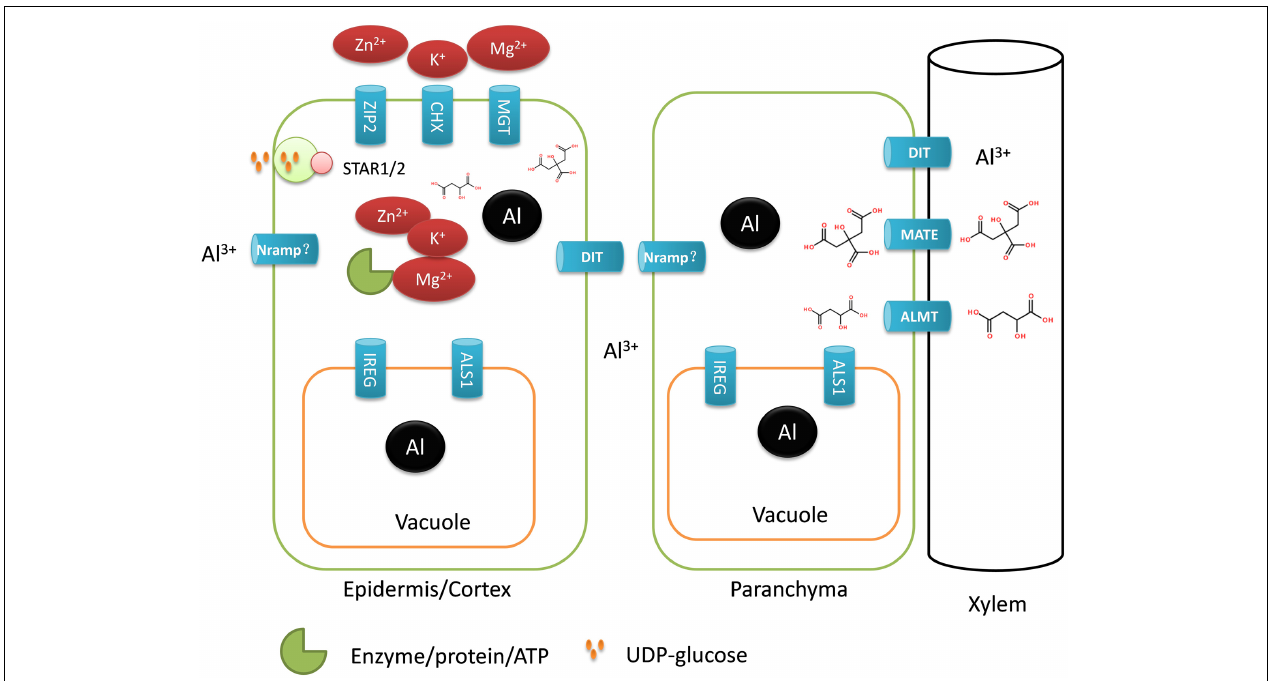
FIGURE 3 | Schematic model for the involvement of putative transporter genes in Al uptake, detoxification, compartmentation, and translocation in buckwheat. ALS1, aluminum sensitive1; DIT, divalent ion transporter; CHX, CATION/H + EXCHANGER; MGT, magnesium transporter; ZIP2; ZINC INDUCED FACILITATOR-LIKE 1; STAR1/2, sensitive to aluminum rhizotoxicity1/2; ALMT, aluminum-activated malate transporter; MATE, multidrug and toxic compound extrusion; IREG, IRON-REGULATED PROTEIN; Nramp, natural resistance-associated macrophage protein; “?” represents remains to be identified.